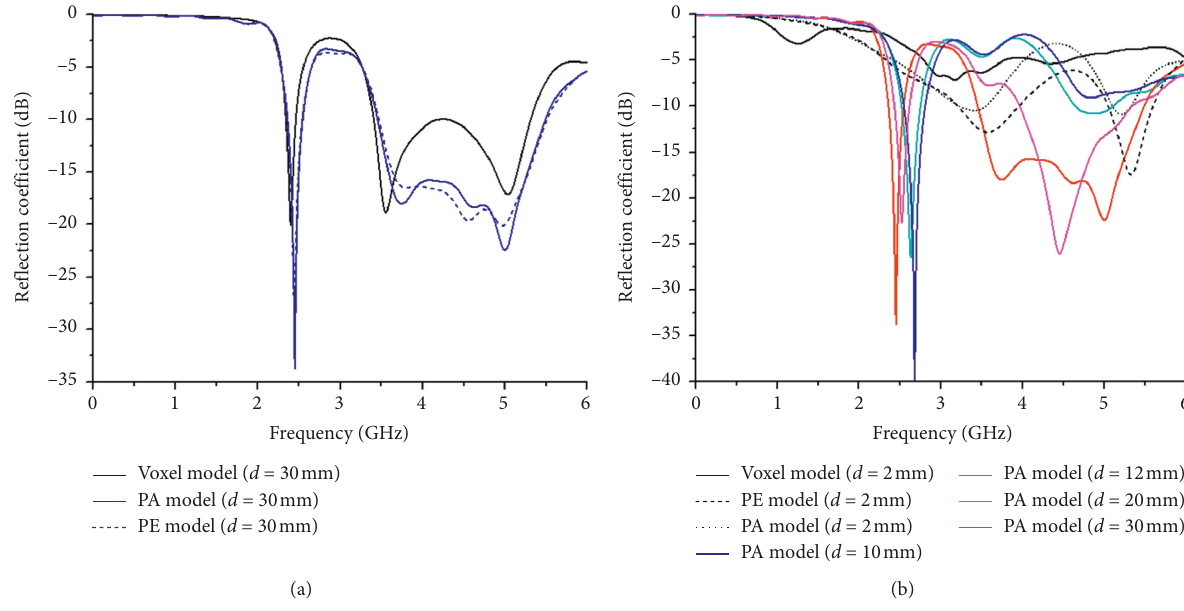
Figure 17: Simulated reflection coefficient of the proposed reflector-backed antenna next to the multilayer and voxel models for (a) different studied cases at d � 30 mm and for (b) PA at several distances d . Table 6: Simulated input impedance and realized gain of the antenna at 4GHz next to the multilayer and voxel